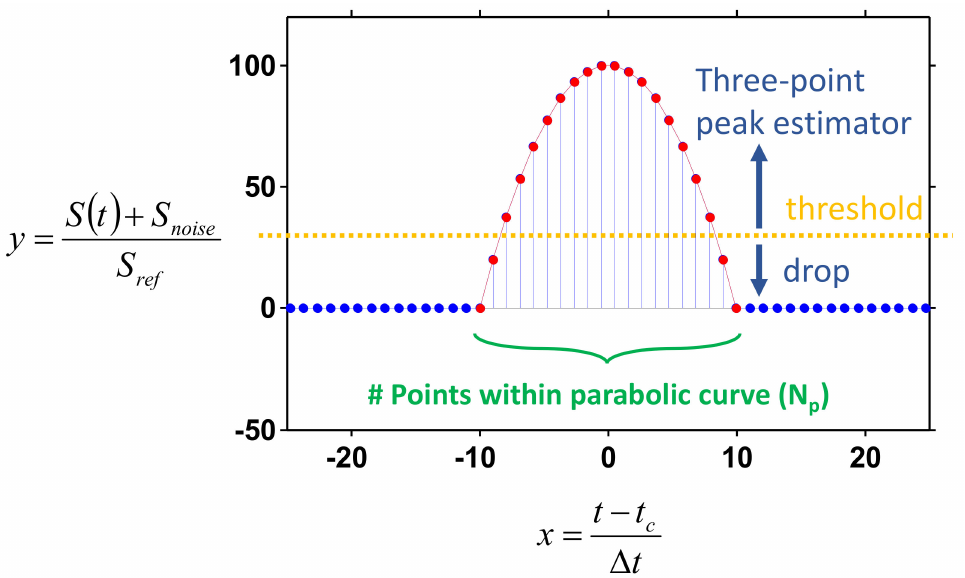
Figure 1. Logical curve for analyses and illustrations. S(t) is the signal time